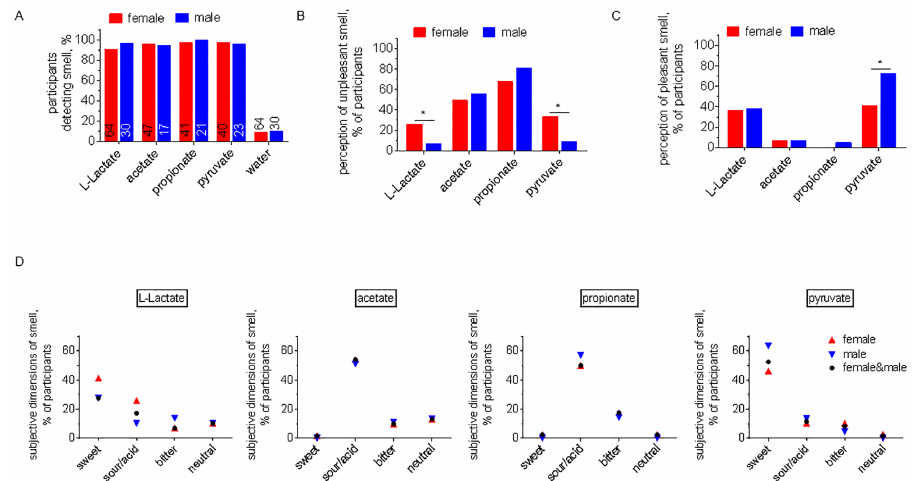
Fig 3. Gender-dependent differences in L-Lactate odour perception by humans. A. Gender- dependent differences in odour discrimination . Similarpercentagesof female and male participantswere able to discriminate an odour in solutionsof L-Lactate, pyruvate, acetate and propionate.Numbers indicate amount of participants tested with a smell. B. Gender-dependent differences in ‘unpleasant’ odour perception . L-Lactateand pyruvate were perceivedas repulsiveby more women than men (L-Lactate: 25.9% vs 6.9%; pyruvate: 33.3% and 9.1%). Similar percentagesof female and male participants rated the odoursof acetate and propionateas unpleasant. C. Gender-dependent differences in ‘pleasant’ odour perception . Almost twice more men than women rated the smell of pyruvate as appealing(72.7% vs 41%). Similar percentages of men and women rated the odour of L-Lactate, acetate and propionateas pleasant. D. Gender-dependent characterisation of test odours . L-Lactate, pyruvate, acetate and propionatewere rated similar by men and women in respect to the dimensionof their smell/taste. Most participants, independent of gender, indicatedthem as sweet and sour/acid, respectively.Lactate and water: n(F) = 64, n (M) = 30; acetate: n(F) = 47, n(M) = 17; propionate:n(F) = 41, n(M) = 21; pyruvate: n(F) = 40, n(M) = 23. * p < 0.05,Fisher’s exact test.